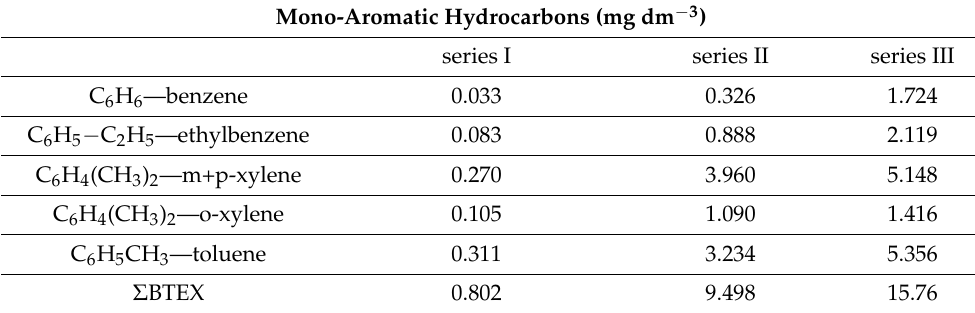
Table 1. Quality of model water intended for technological tests in terms of BTEX (benzene; ethyl- benzene; toluene; ortho-, meta-, and para-xylene) content. Σ BTEX Absorbance (UV 254 ) Water Type Symbol mg dm − 3 1/cm Min Max Surface Water 2 0.097 0.122 0.000 1.700 Surface + MP * Water 3 0.202 0.511 0.800 17.00